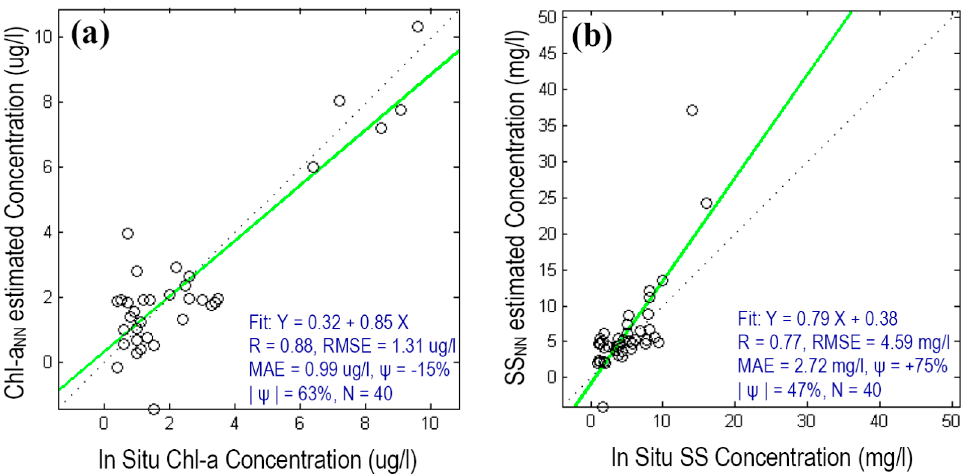
Figure 3. Validation of the regional neural network models for ( a ) Chl-a and ( b ) SS concentrations estimation using 40 coincident data points (for 2011 and 2012).